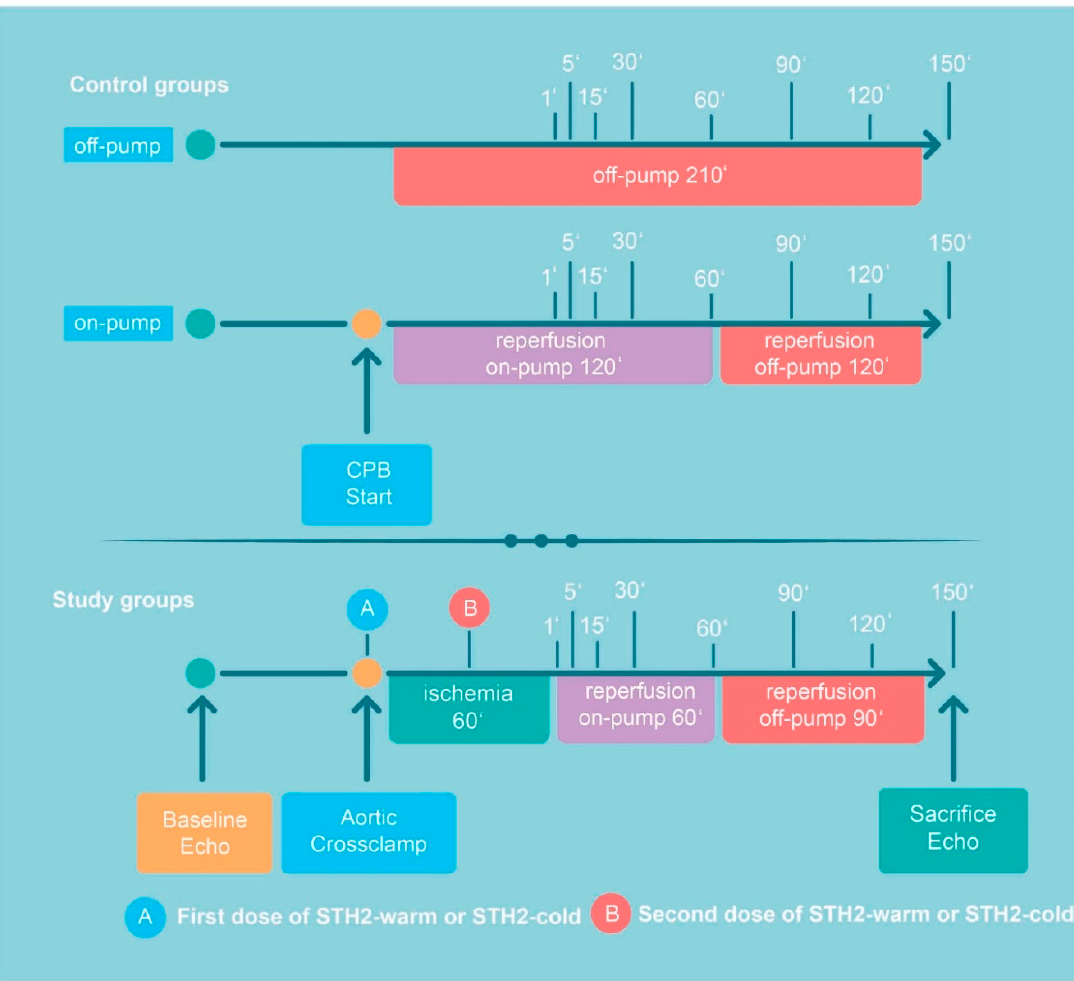
Figure 1. Timeline of the experimental protocol. After baseline haemodynamic and echocardiography measurements pigs were randomised to the following groups: (1) in the off-pump group, after sternotomy, pigs were heparinised (300 IU/kg) and after 210 min, sacrificed. (2) In the on-pump group, no aortic cross-clamping was performed and, consequently, instead of ischemia (60 min), on-pump reperfusion was prolonged for 60 min. In the STH2-warm group and STH2-cold group, aortic cross-clamping was performed followed by 60 min of ischemia, 60 min of on-pump and, finally, 90 min of off-pump reperfusion. Before sacrifice, echocardiography was repeated. A indicates administration of the first dose of STH2-warm or STH2-cold cardioplegic solution (1000 mL after aortic cross-clamping), B indicates administration of the second dose of STH2-warm cardioplegic solution or STH2-cold cardioplegic solution during ischemia (500 mL). The indicated times refer to the sampling points. CPB: cardiopulmonary bypass and STH2: St Thomas Hospital No. 2.